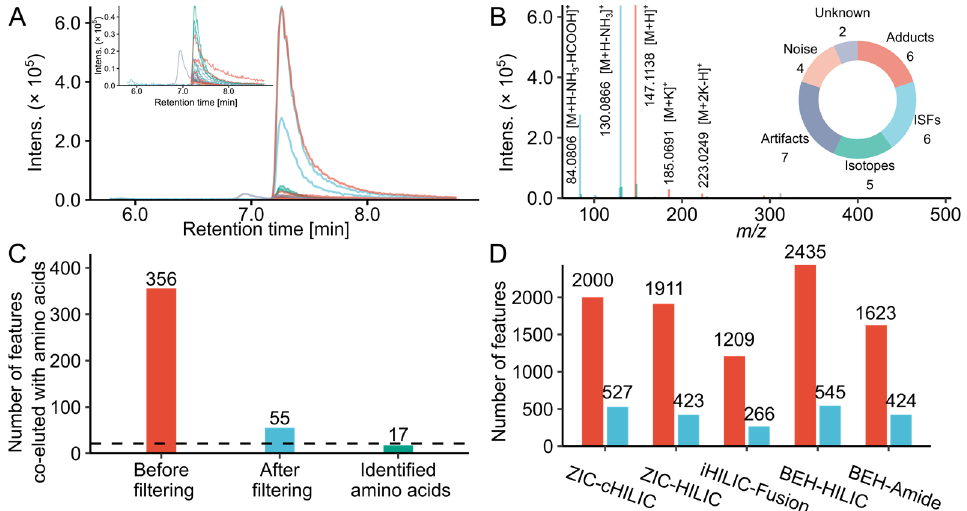
Figure 1. Feature filtering results of model systems. ( A ) Extracted ion chromatograms of lysine and its co-eluted MS features grouped by CAMERA in a glucose and lysine model system analyzed by iHILIC-Fusion. ( B ) Interpretation of the MS features grouped with lysine. Top right: Pie chart of the proportions of peaks categorized by the annotations. ( C ) The number of features co-eluted and grouped with amino acids in the model systems mixture of twenty-one amino acids (MSM1) before and after filtering analyzed by iHILIC-Fusion. ( D ) The total feature number detected in MSM1 before (red) and after filtering (blue) analyzed by different HILIC columns.